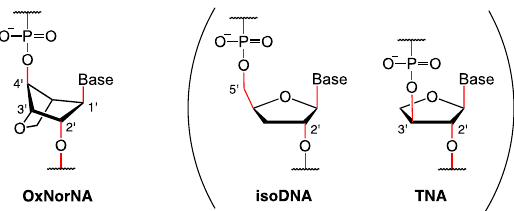
Figure 2. Structures of artificial nucleic acid bearing an oxanorbornane scaffold (OxNorNA), isoDNA, and TNA.